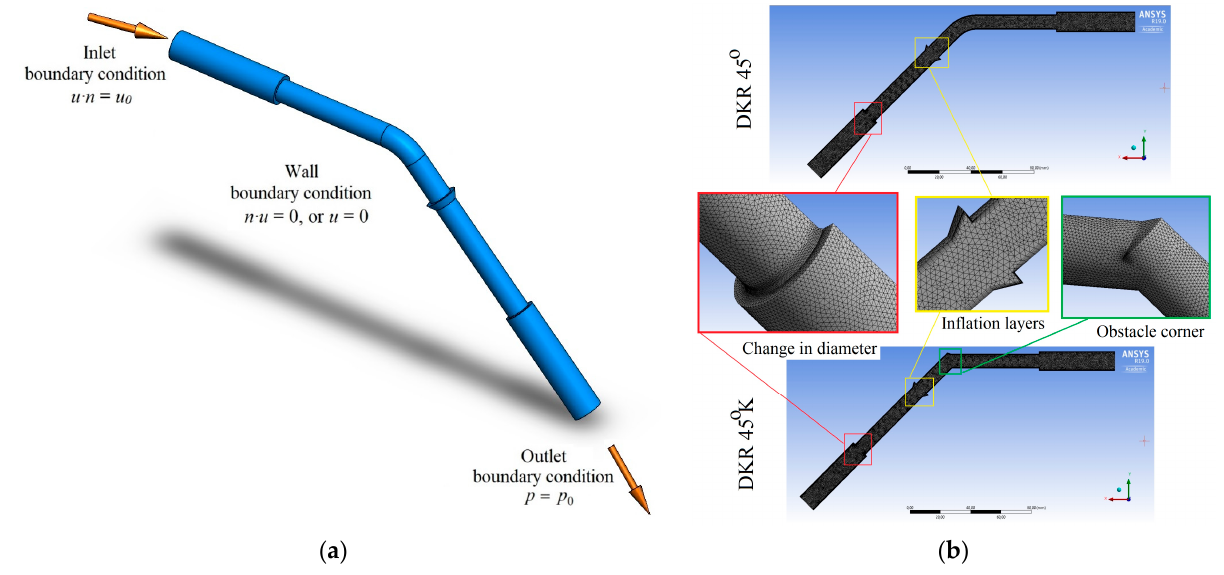
Figure 4. Views of the numerical simulation model for angular fitting connections (1/2): ( a ) boundary conditions of the fluid flow for ANSYS fluent simulation; ( b ) example mesh of the numerical model.